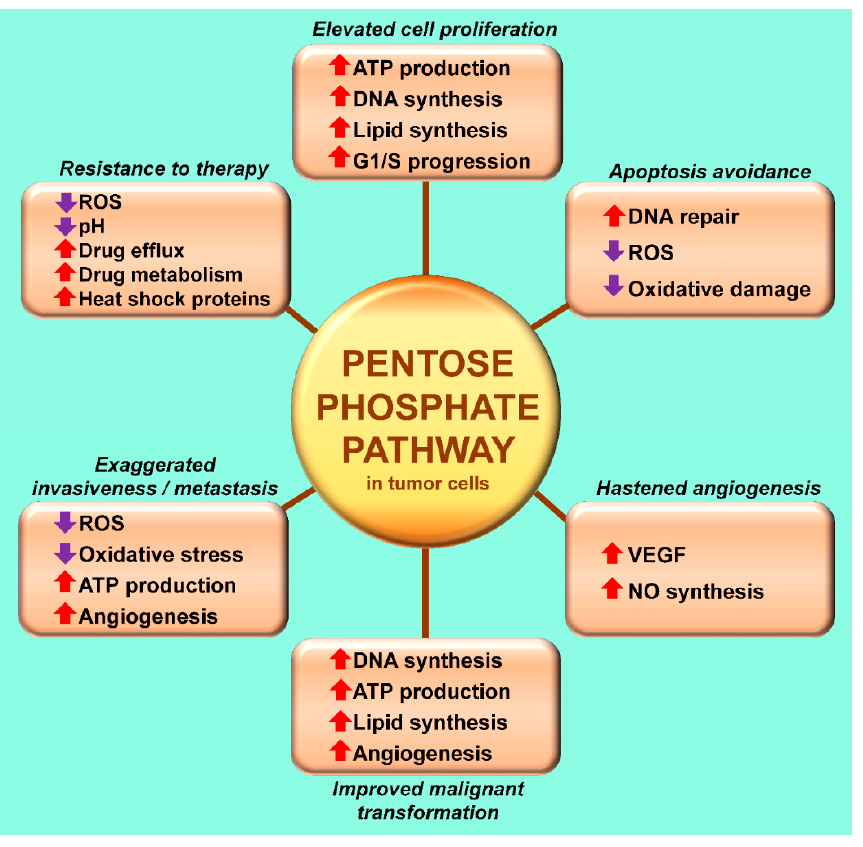
Figure 4. The pentose phosphate pathway becomes highly activated during aerobic glycolysis (the Warburg effect) (Figure 3) when pyruvate dehydrogenase kinase inhibits pyruvate dehydrogenase complex. This pathway, the initial molecule of which is glucose-6-phosphate, generates the necessary molecular building blocks for the synthesis of nucleotides, which supports cell proliferation, invasiveness and metastasis of cancer cells. Herein, the authors propose that inhibiting the Warburg effect, which interferes with processes that accelerate cell proliferation, etc., may be a common mechanism for melatonin to modulate disease progression not only in cancer but also in other diseased cells that utilize aerobic glycolysis. G1/S = growth 1 to synthesis; ROS = reactive oxygen species; VEGF — vascular endothelial growth factor.